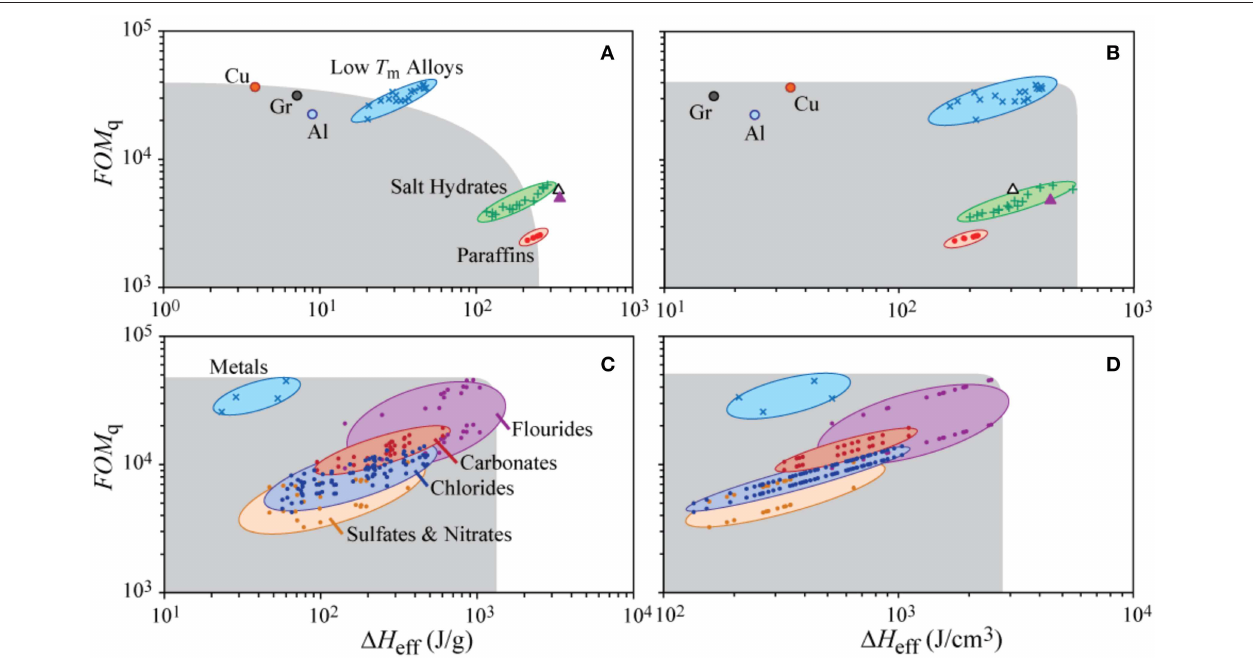
FIGURE 7 | Thermal Ragone plot of (A,B) low-temperature PCMs ( T m < 300 ◦ C) (Chase, 1998; Solder Alloy Directory, 2008; Lide, 2010; Shamberger et al., 2017), along with three potential high- k materials: copper (Cu), graphitized carbon fiber (Gr), and aluminum (Al), and (C,D) high-temperature PCMs ( T m > 300 ◦ C) (Janz et al., 1978, 1979; Chase, 1998; Solder Alloy Directory, 2008; Kenisarin, 2010; Lide, 2010; Shamberger et al., 2017), illustrating the cooling power figure or merit η q calculated for 1 T 10 ◦ C, as a function of the specific effective storage enthalpy (A,C) , and the volumetric effective storage enthalpy (B,D) . PCMs are clustered by = materials class as labeled. Properties of water (empty triangle) and erythritol (filled triangle) are also illustrated. Shaded gray region represents sub-optimal Pareto